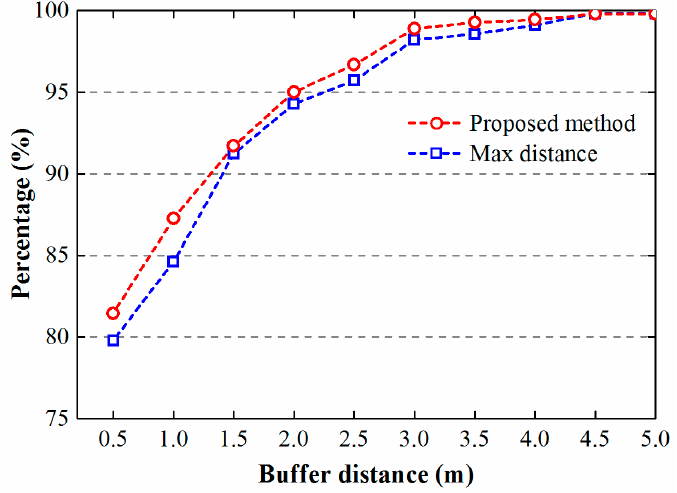
Figure 10. Percentages of points versus different buffer distances.